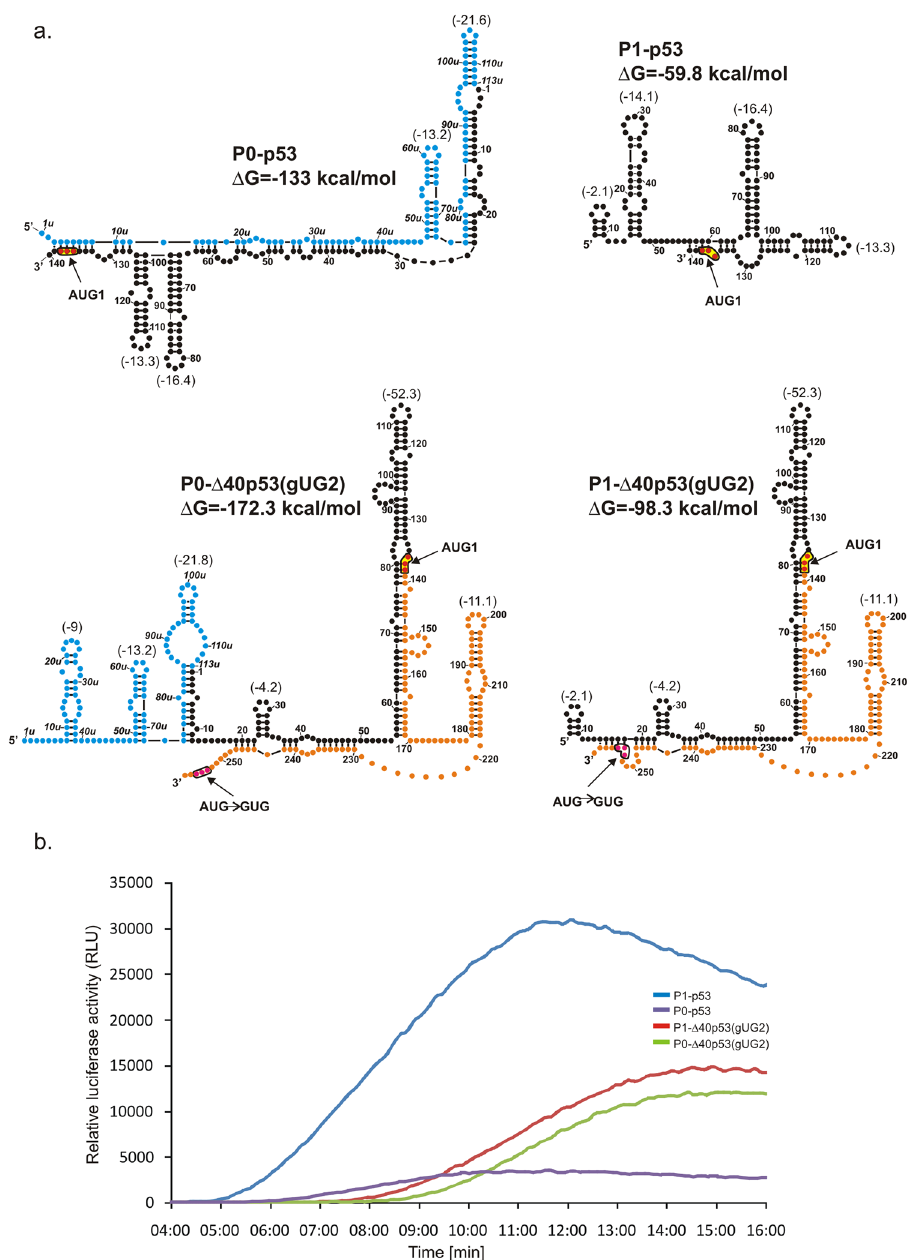
Figure 3. Secondary structure models of the 5 ′ -terminal regions of mRNA constructs with single initiation AUG1 codon and kinetics of their in vitro translation followed by a luciferase reporter gene assay. ( a ) Secondary structure models of the 5 ′ UTRs of constructs: P0-p53, P1-p53, P0- Δ 40p53(gUG2), and P1- Δ 40p53(gUG2). The predicted Δ G value (kcal/mol) for each 5 ′ UTR is indicated and Δ G values of selected structural motifs are also shown in brackets. Colours denote parts of the 5 ′ -terminal region of p53 mRNA: blue – the region between P0 and P1 transcription promoters; black - the 5 ′ untranslated region downstream P1 promoter; orange - p53 open reading frame (ORF). ( b ) The relative luciferase activity (RLU) was measured during translation of each mRNA construct using a luminometer in 1 s periods with 9-second intervals, for 16 minutes. The data illustrate approximate values of maximal translation efficiency for each